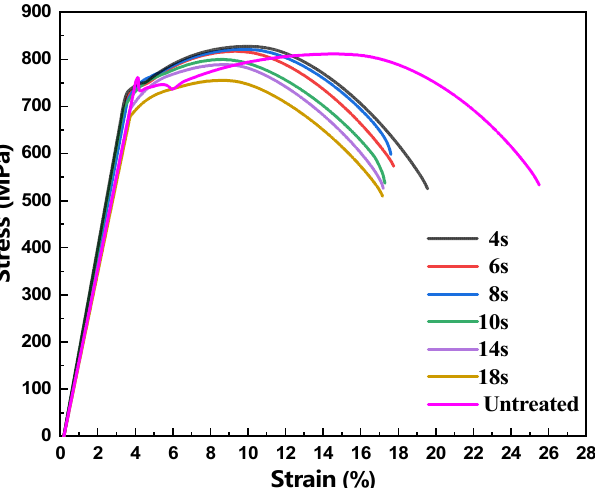
Figure 8. Thermal simulation of the micro-zone tensile stress–strain curves when T max = 1250 °C at different t 8/5 values.